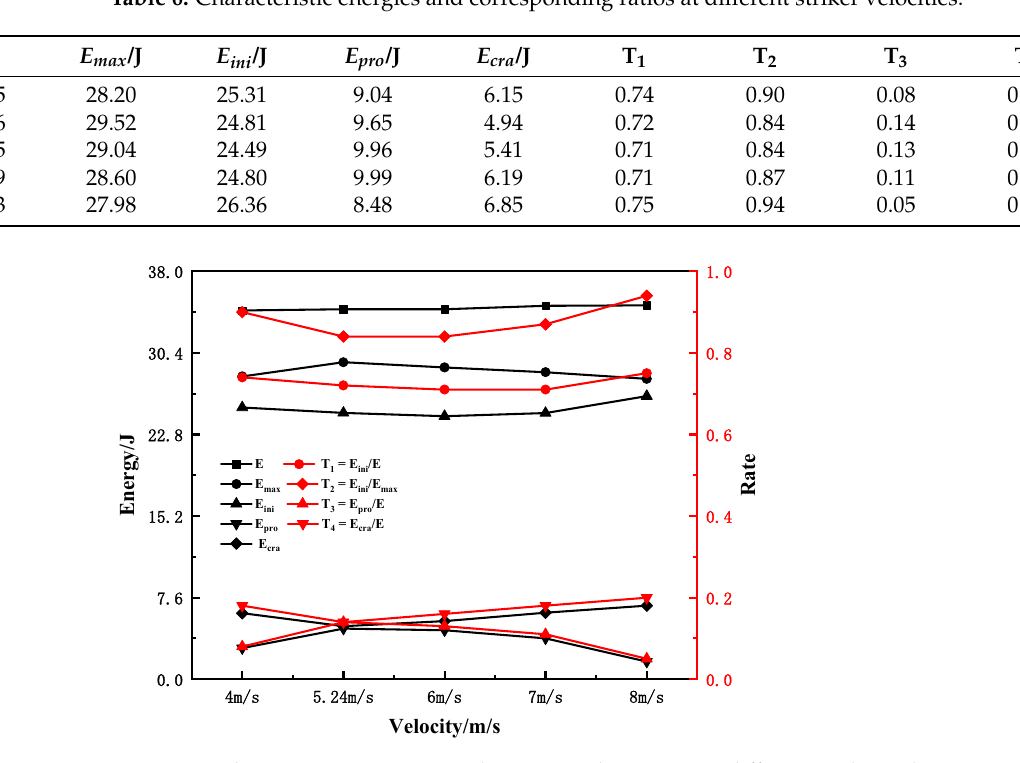
Figure 18. Characteristic energies and corresponding ratios at different striker velocities.